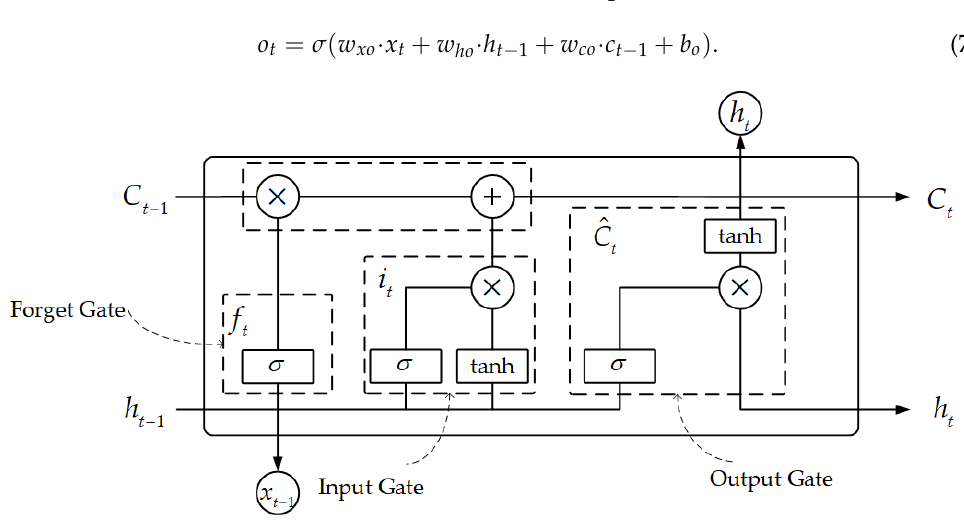
Figure 3. The structure of the LSTM.